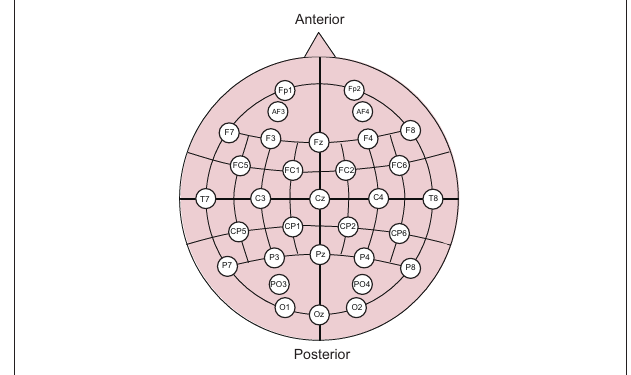
FIGURE 2 | Sensor positions in the EEG experiment. Thirty-two electrodes were used based on the extended international 10–20 system. (Image S4i, Klipsch Group, Inc., Indianapolis, IN) providing auditory stimuli at a sound pressure level of 70 dB.